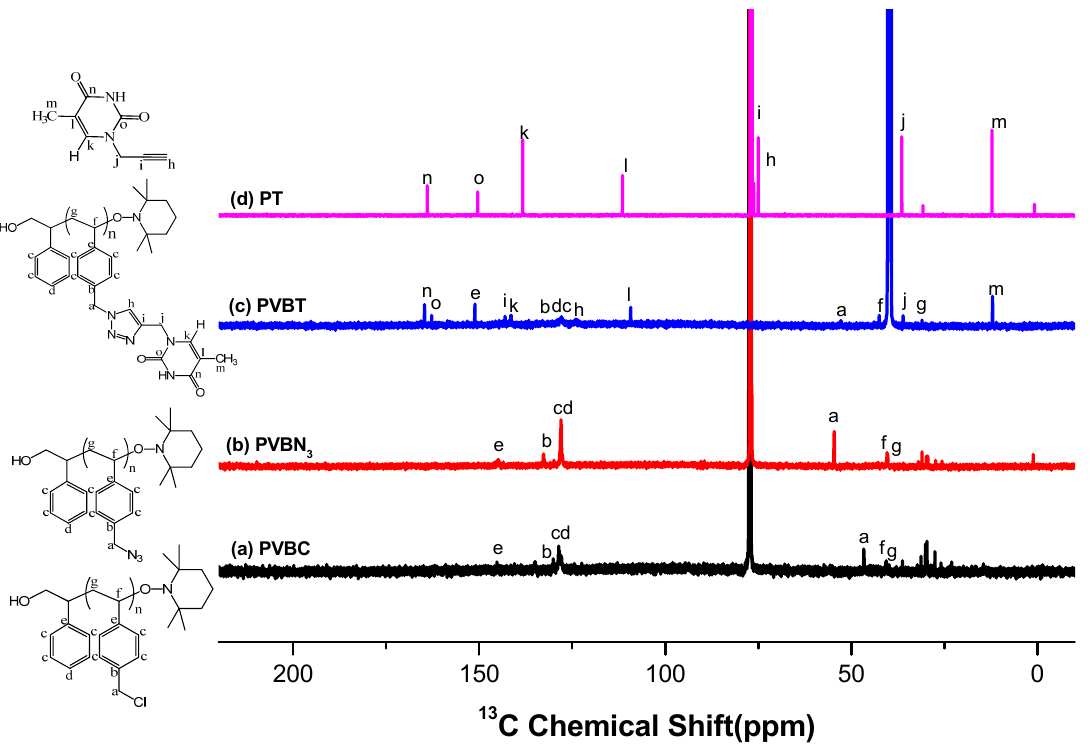
Figure 5. 13 C NMR spectra of ( a ) PVBC in CDCl -DMSO; and ( d ) PT in CDCl d 6